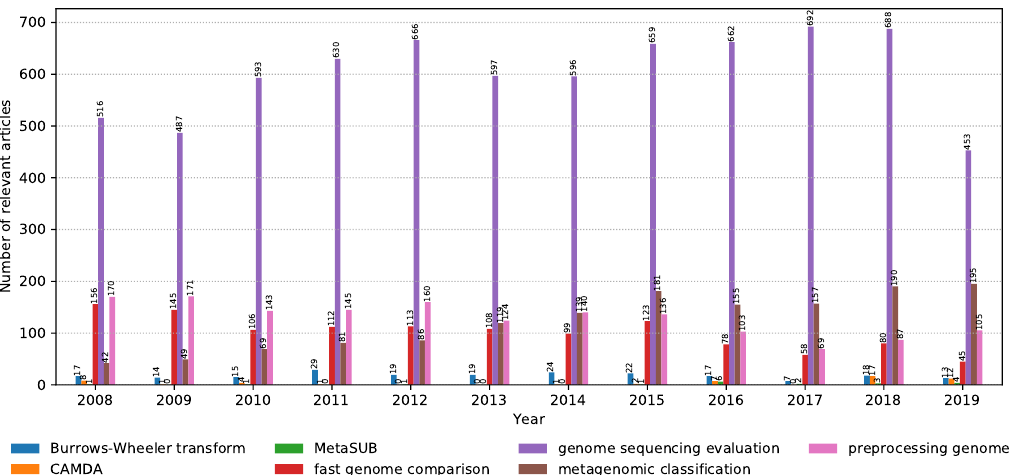
Figure 6. Distribution of the number of relevant articles for each keyword with respect to the publication year from 2008 to November 2019.